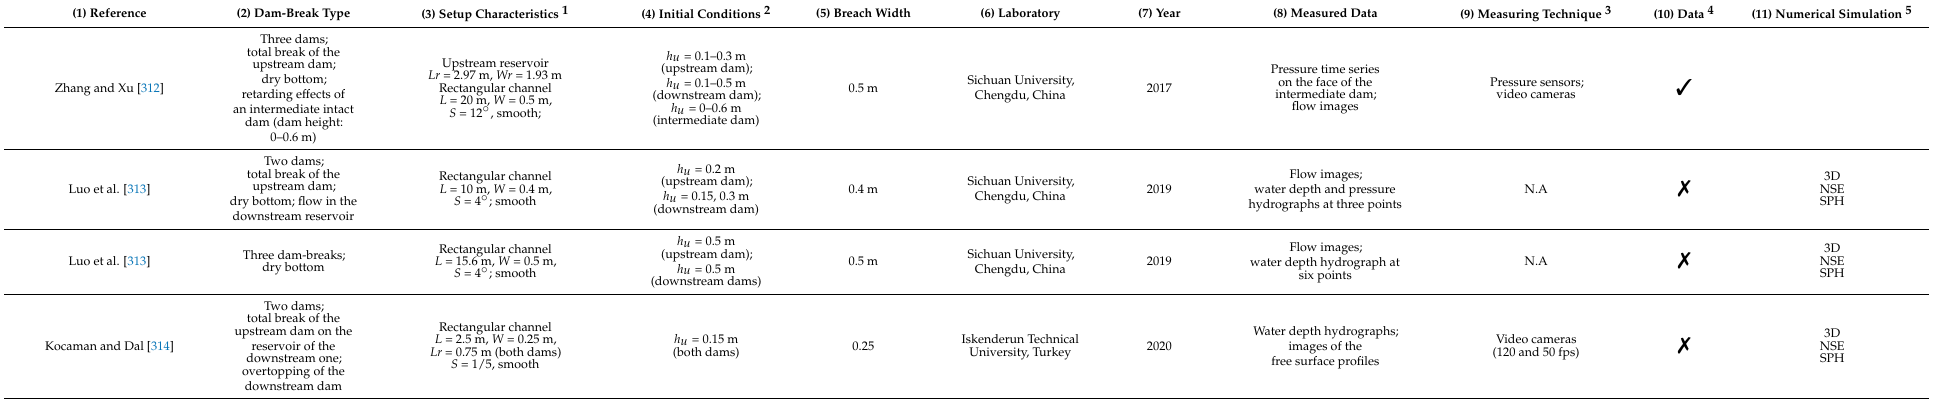
Table 1. Basic experimental investigations of fundamental dam-break wave physical characteristics.